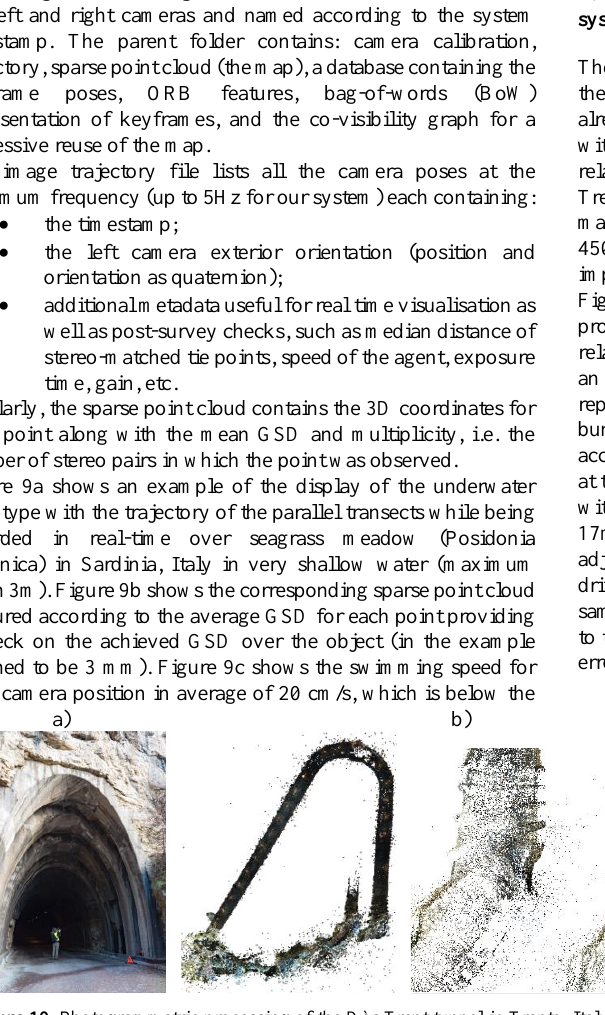
Figure 10. Photogrammetric processing of the Dòs Trent tunnel in Trento, Italy showing the main entrance (a) where the loop closure is analysed. In (b) the sequential image orientation (no loop closure) is done without stereo baseline constraints in the bundle adjustment, in (c) baseline constraints are added and in (d) the poses of (c) are used as initial approximation for a more exhaustive matching (loop closure). For more details refer to subsection